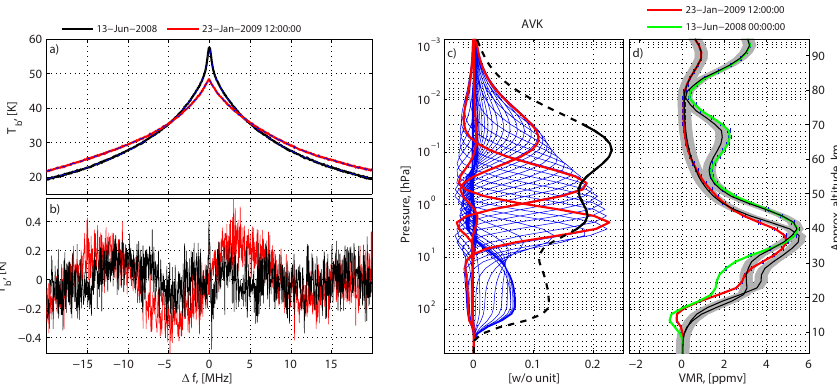
Figure 3. (a) Tropospheric- and baseline-corrected spectra for noon summer (red) and midnight winter (black), along with the fitted spectra (dashed blue). (b) Residuals between the corrected spectrum and the fitted spectrum for noon summer (red) and midnight winter (black). (c) The AVK from the retrieval, solid red lines are the AVK at 2.21hPa, 0.39hPa and 0.04hPa (approximately 41km, 54km and 71km). The black line is the measurement response from the AVK divided by 5, where the solid (dashed) part indicates the area of at least (less than) 0.8 measurement response. (d) Summer noon (red) and midnight winter profiles (green) with their barely visible random measurement error (blue error bars). The thin black solid line is the a priori with the grey shade showing the 1- σ standard deviation of the a priori used in the